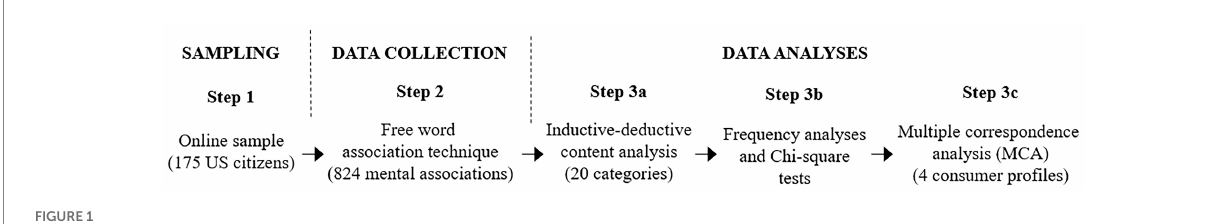
FIGURE 1 Overview of the methods applied for sampling, data collection, and data